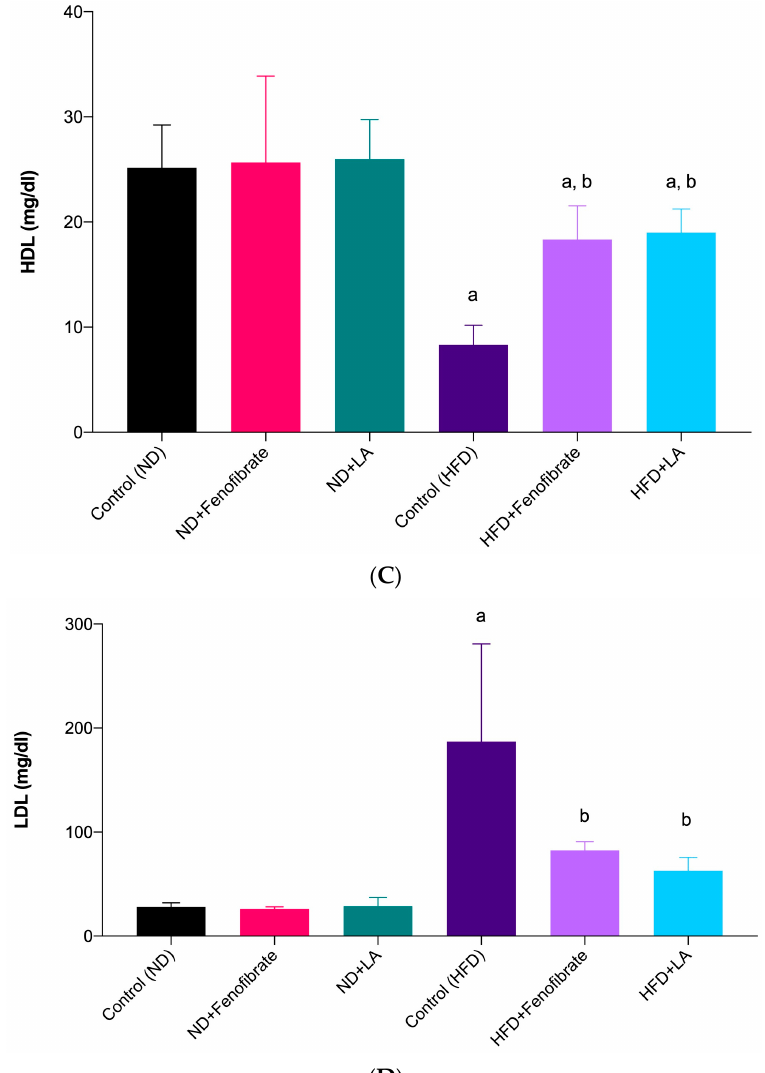
Figure 1. TC ( A ), TG ( B ), HDL ( C ), and LDL ( D ) levels in the serum of rats fed with a high-fat diet and a normal diet, treated with fenofibrate (60 mg/kg) and linoleic acid (5 mg/kg) for 28 days. Data are presented as mean ± SD ( n = 6). a p < 0.05 vs. Control (ND); b p < 0.05 vs. Control (HFD). Normal diet: ND; high-fat diet: HFD; linoleic acid: LA; TC: total cholesterol: TC; triglycerides: TG; high-density lipoprotein: HDL; low-density lipoprotein: LDL.